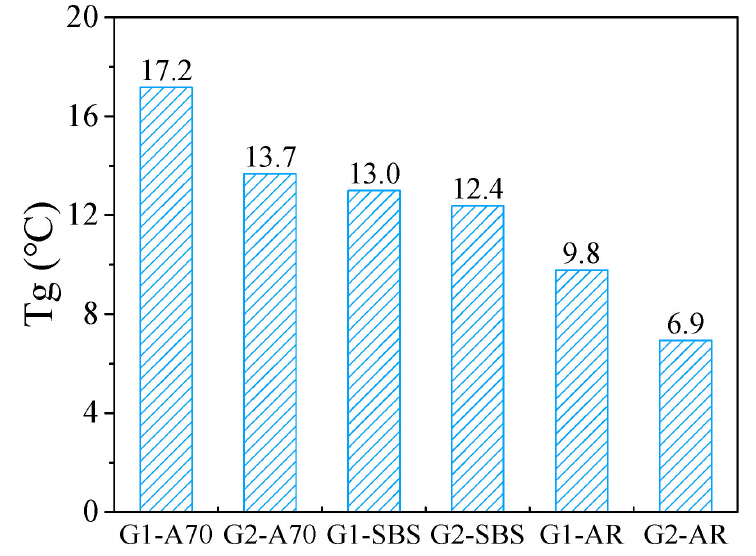
Figure 8. Phase transition temperature T g